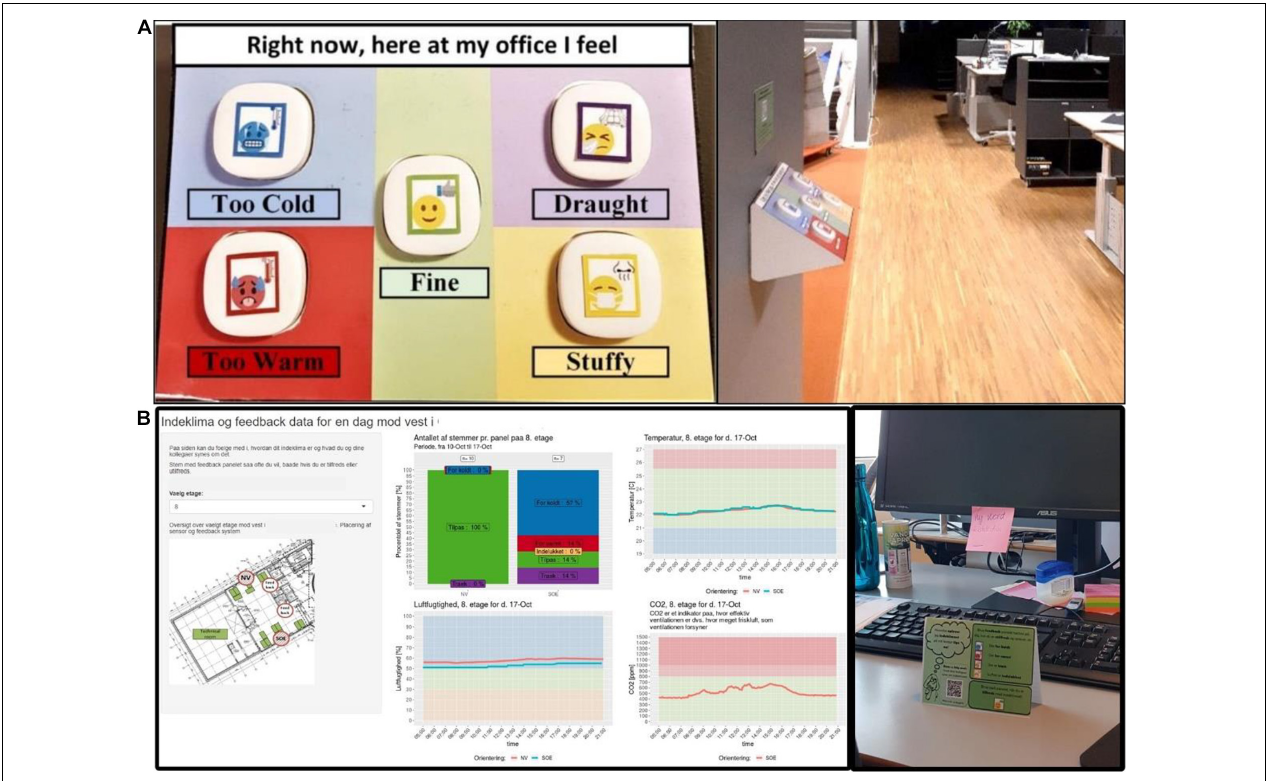
FIGURE 1 | (A) Interface of TiAQ and an example of the mounting location of TiAQ in one of the studied office spaces. (B) Overview of web-dashboard (left) and information flyer